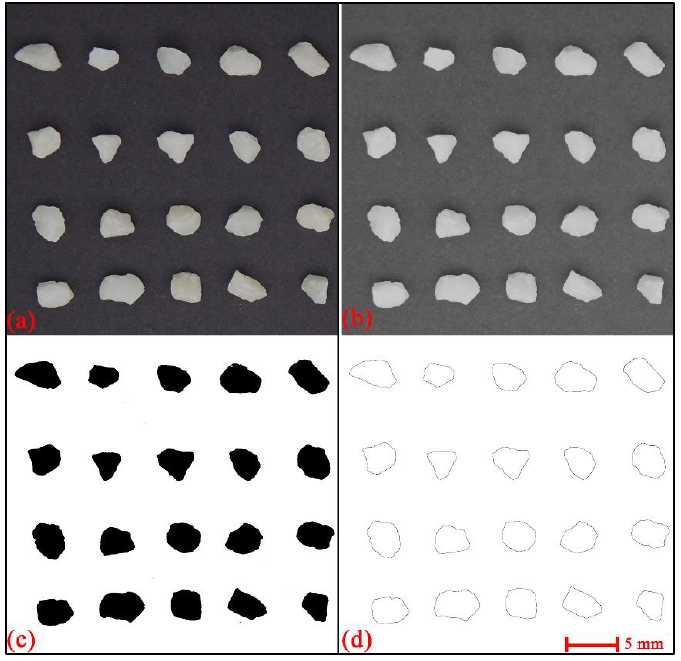
Figure 4. Image conversion and particle edge recognition. ( a ) Original RGB image. ( b ) Converted into an eighth-order grayscale image. ( c ) Thresholding of eight-bit image. ( d ) Drawing outlines. Using 221 tests of effective irregular-shaped sand settlement experimental data ob- tained in the experiment, the equivalent diameter d eq and circularity c were statistically analyzed, and the results are shown in Figure 5. The circularity c of most sand particles is concentrated between 0.7 and 0.8.